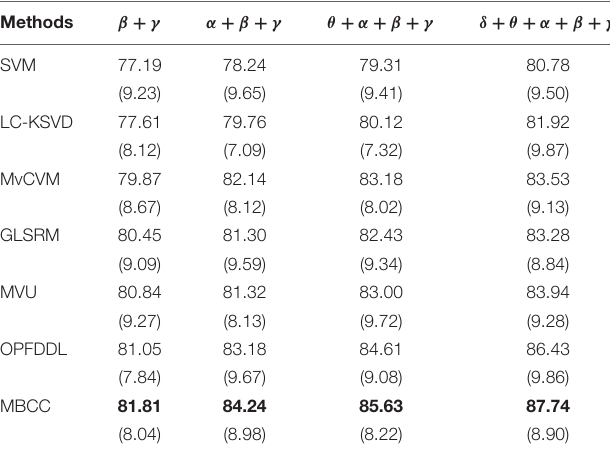
TABLE 2 | The accuracy (standard deviations) of all methods on SEED dataset in session 1.